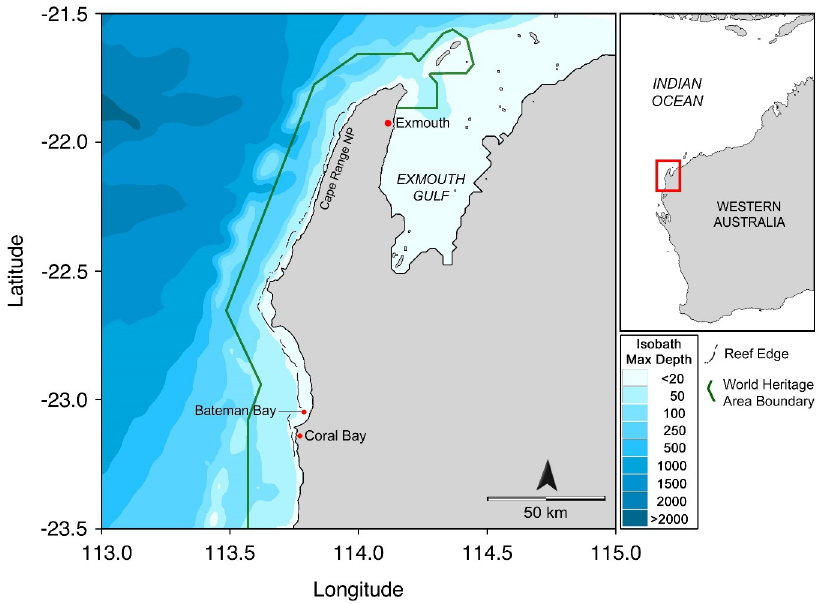
Fig 1. Map of the study area showing the outline of the Ningaloo Coast World Heritage Area in Western Australia, and key reef manta ray Mobula alfredi monitoring areas: Bateman Bay to the north of the Coral Bay township, waters to the western side of Cape Range National Park and the northern end of the Exmouth Gulf near Exmouth township. Figure created using the R package ‘marmap’ [44] with bathymetric data from the ETOPO1 database [45] and the marine component of protected area bounds from The World Database on Protected Areas [46]. Major reef features were added in Adobe Photoshop, from geographically aligned Landsat-8 imagery courtesy of the U. S. Geological